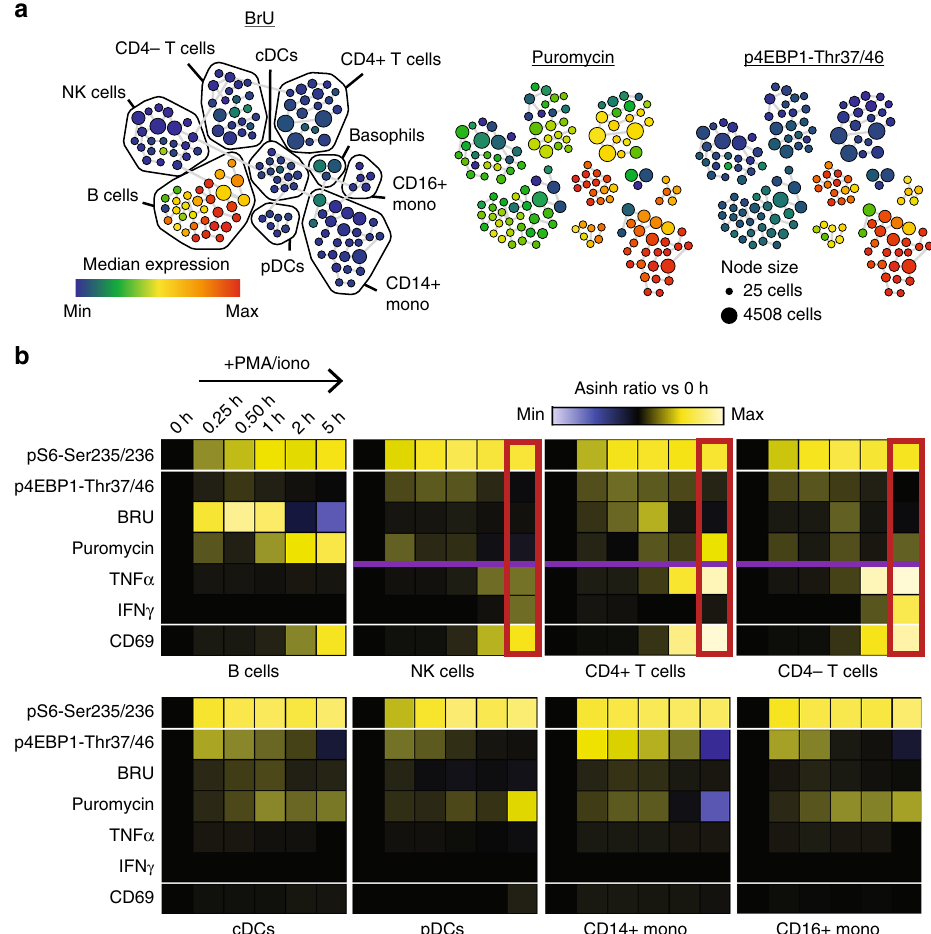
Fig. 4 Activation of de novo RNA, protein, and cytokine synthesis occurs sequentially during ex vivo peripheral human immune activation. a Manually annotated SPADE map of unstimulated, in silico gated, PBMCs clusters, color overlaid with the median baseline incorporation of BRU (left), puromycin (center), and median baseline phosphorylation of 4EBP1-Thr37/46 (right). b A heat map summary, ordered by stimulation time and grouped by cell phenotype, of peripheral immune cell subsets with PMA/ionomycin activation, each parameter normalized to 0 h (ratio of transformed cluster median at given time point relative to t = 0 h). (ArcSinh ratio color scales; p4EBP1, BRU, Puromycin, TNFalpha, IFNgamma: − 1 to 1; pS6, CD69: − 3 to 3). Number of cell events displayed; 95,000 to 150,000 mononuclear cell events for each time point, experiments were performed multiple times, with representative maps and plots